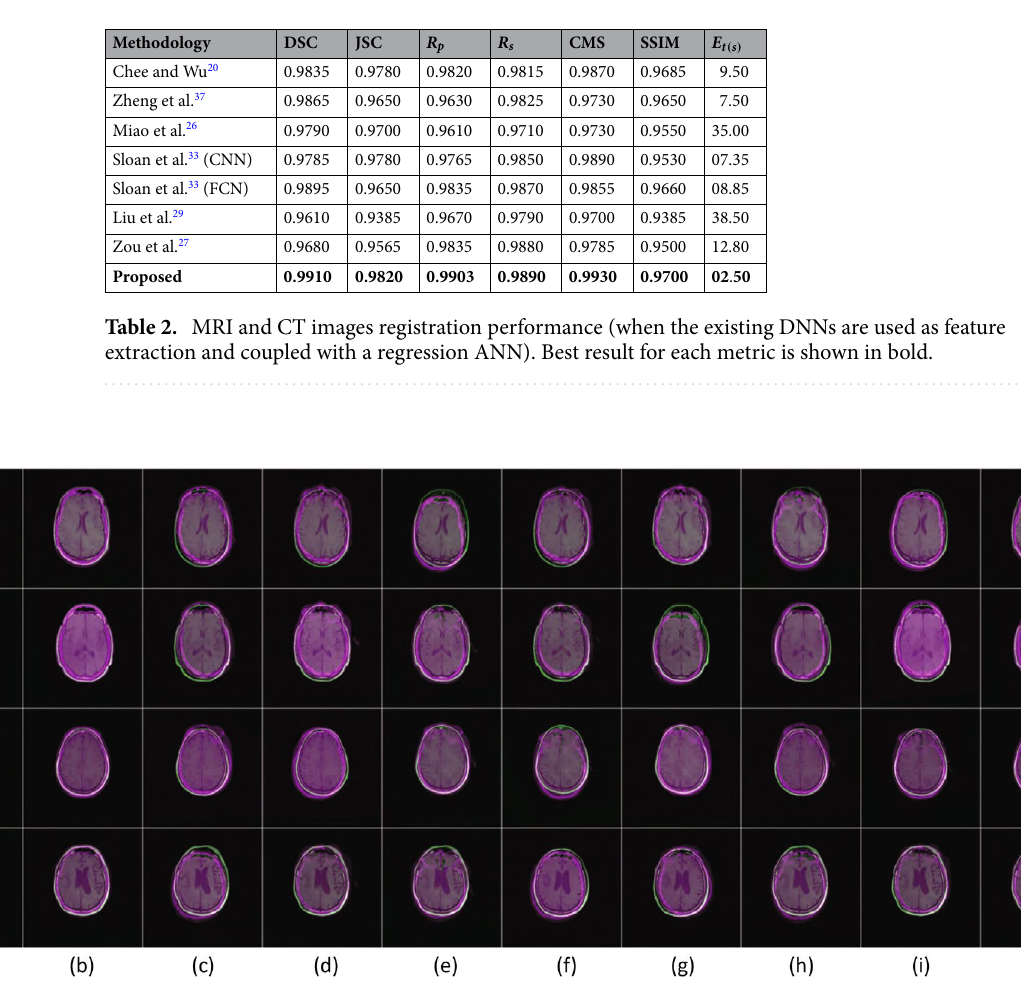
Figure 9. Examples of comparative performance of the registration methods. The columns show the axial views of: ( a ) input images, ( b ) ground truth, ( c ) Chee and Wu 20 , ( d ) Zheng et al. 37 , ( e ) Miao et al. 26 , ( f ) Sloan et al. 33 , (CNN) ( g ) Sloan et al. 33 , (FCN) ( h ) Liu et al. 29 , ( i ) Zou et al. 27 , and ( j ) the proposed